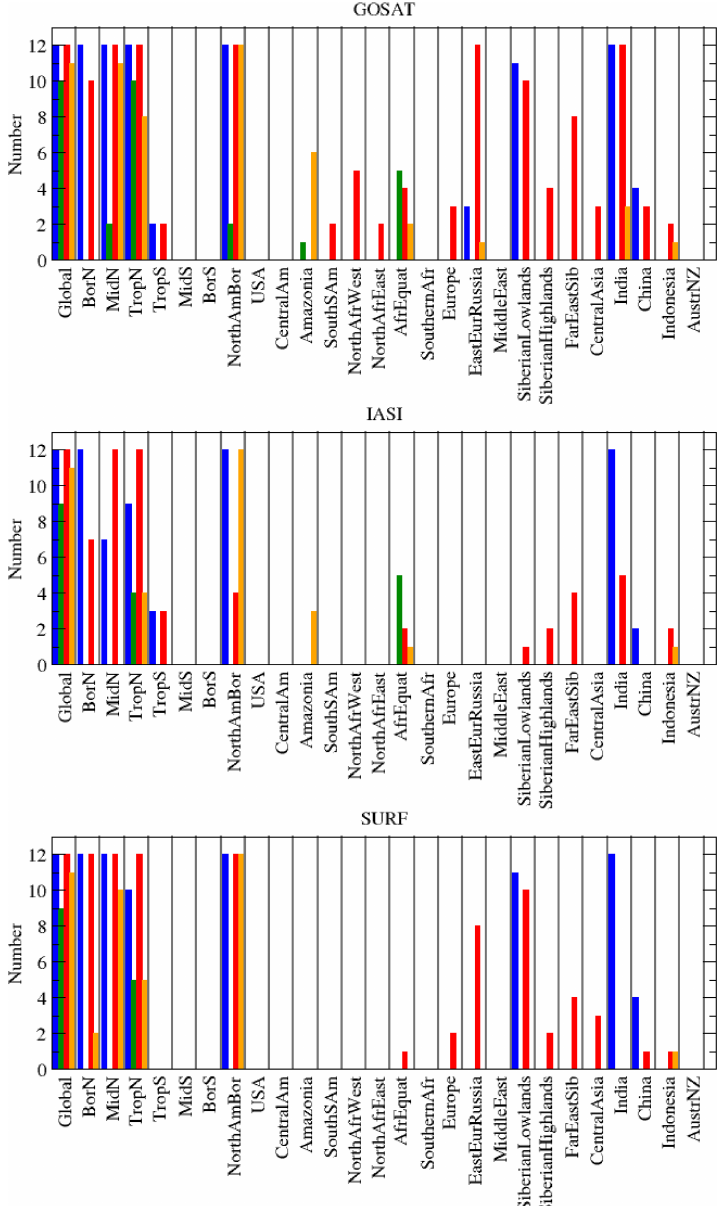
Figure 3. Number of detected seasons over the 12 possible for winter (JFM, blue), spring (AMJ, green), summer (JAS, red) and fall (OND, orange) in the various